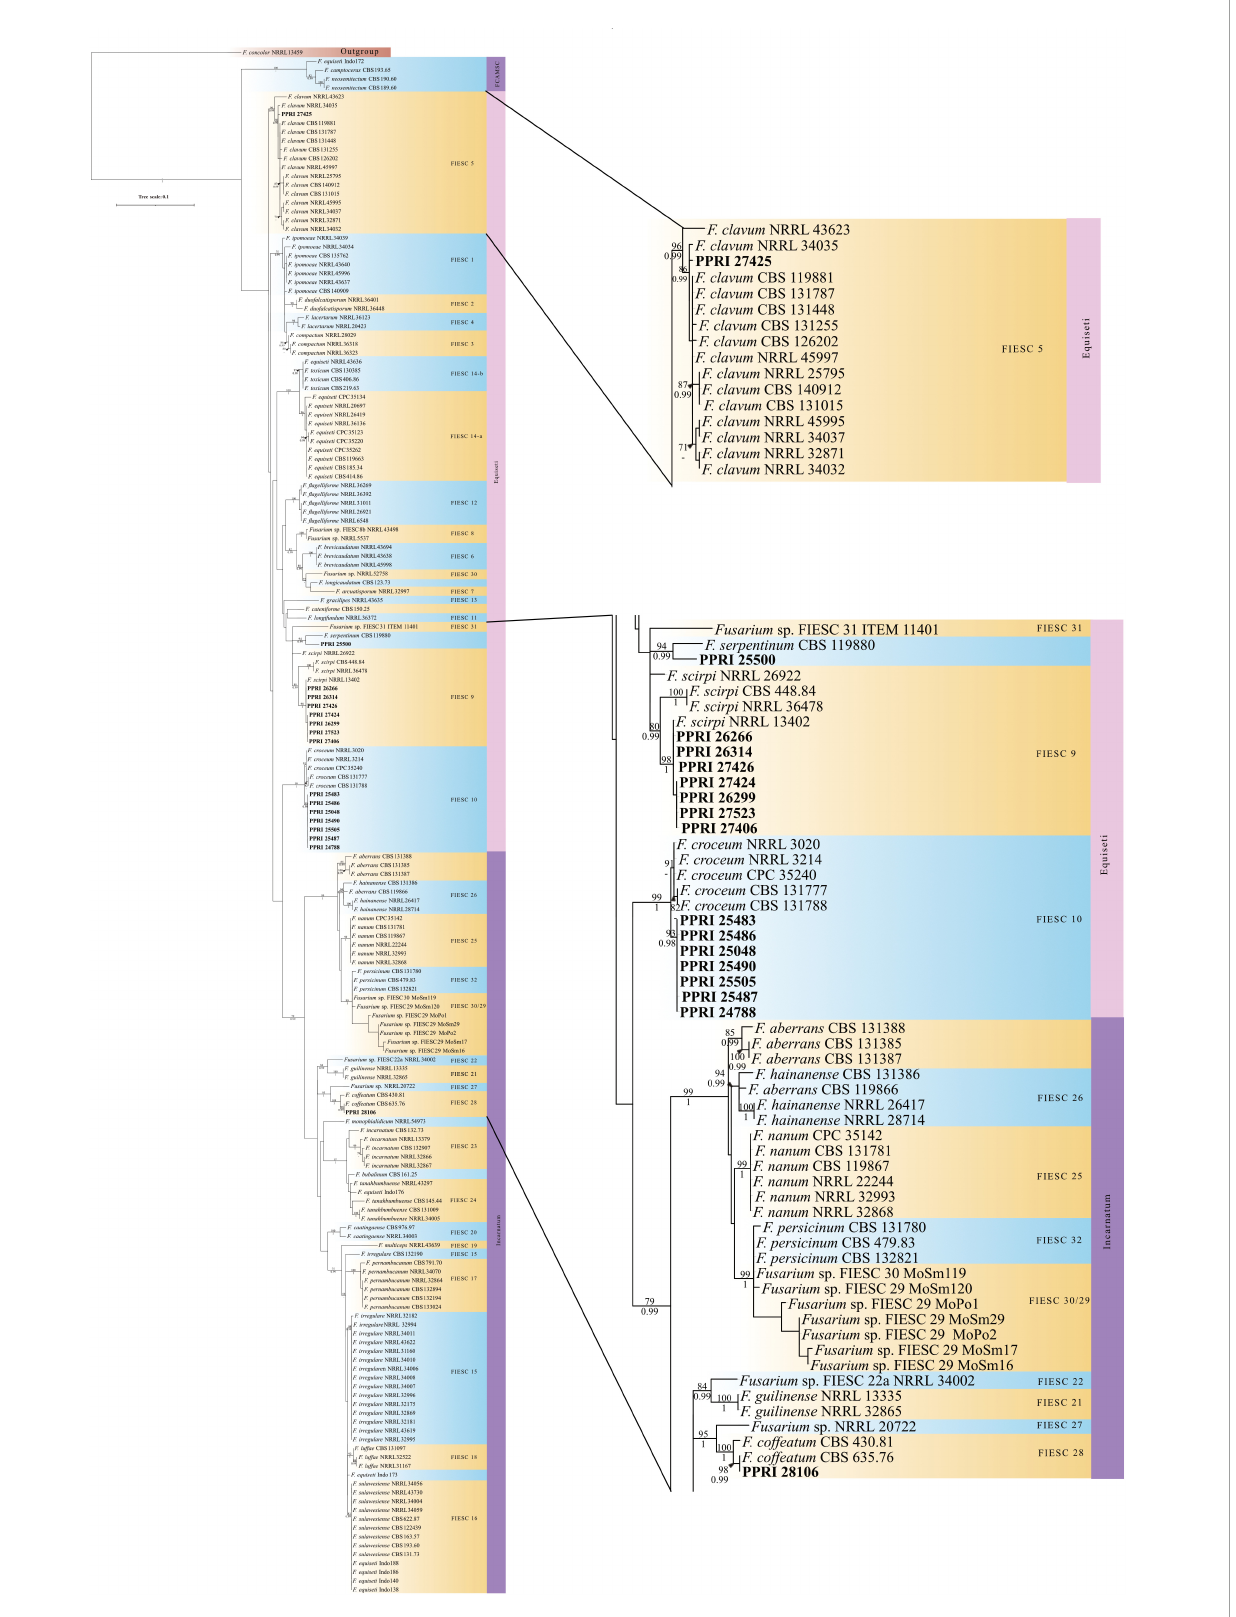
FIGURE7 Phylogenetic tree of the FIESC dataset inferred from the tef-1 α gene region for 175 taxa. Isolates from the GGHNP are indicated by PPRI number and are marked in bold. Branch support values are indicated as ML-BS/PP values ( > 0.98/ > 70%) above the branches at the corresponding nodes.